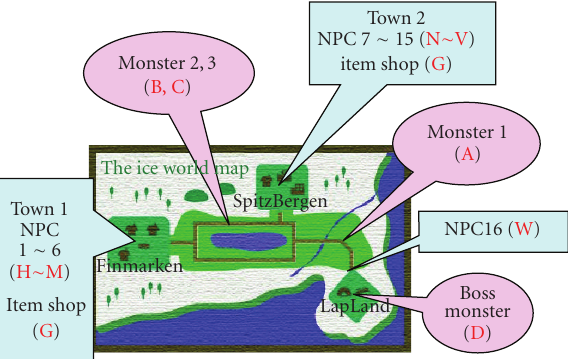
Table 3: List of additional symbols related to actions Attack